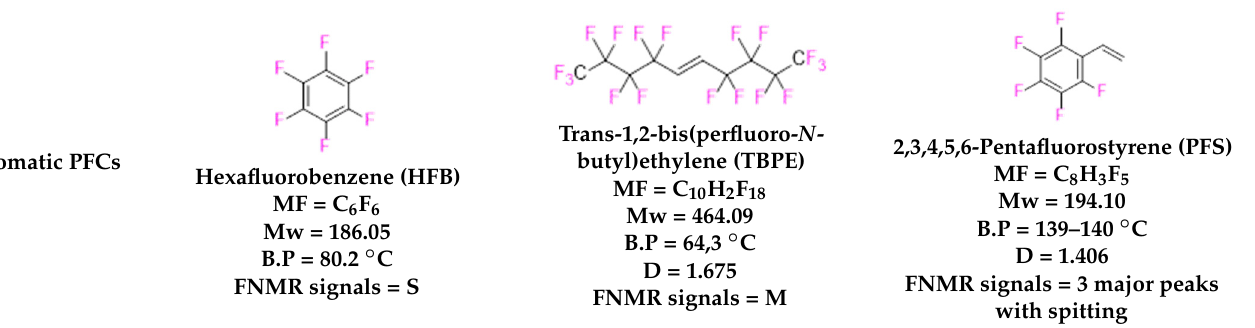
Table 3. Survey of PFC molecules for potential MRI applications. The MF stands for the molecular formula/chemical formula, Mw is the molecular weight in g/mol, B.P is the boiling point, the density (D) is expressed in g/mL at 25 °C (lit.), the FNMR signals are estimated based on the molecular structure and based on the fluorine environment: S—Singlet, M—multiple peaks.